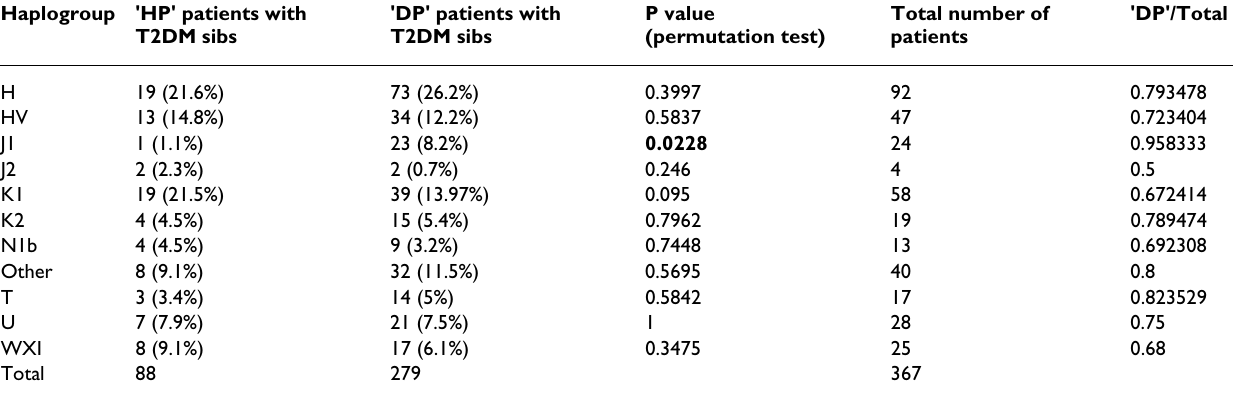
Table 3: Permutation test of haplogroup distribution in 'HP' and 'DP' patients with at least one T2DM sibling. Haplogroup 'HP' patients with T2DM